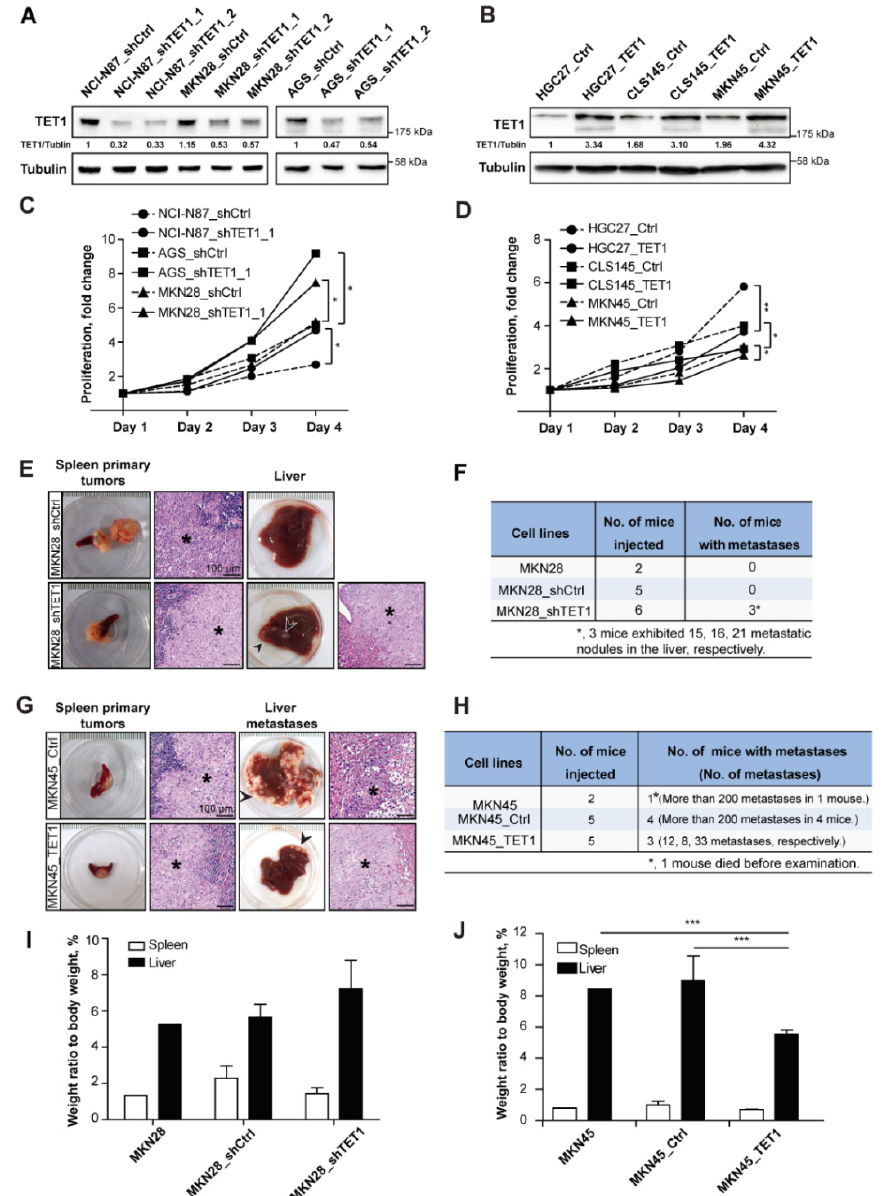
Figure 2. Knocking-down TET1 promotes experimental metastasis, while TET1 overexpression inhibits metastasis in the liver. ( A ) Immunoblot analysis showing TET1 expression in NCI-N87, MKN28, and AGS cells transduced with shTET1 or scrambled shRNA as control (shCtrl). α -Tubulin was used as loading control. ( B ) Immunoblot analysis showing TET1 expression in HGC27, CLS145, and MKN45 cells transduced with ectopic TET1-expressing or empty vector as control (Ctrl). α -Tubulin was used as loading control. ( C , D ) Relative cell proliferation rates of stable cell lines. ( E , G ) Representative pictures of tumors and H&E staining showing primary tumors in the spleen and metastatic tumors in the liver of mice injected with MKN28 stable cell lines ( E ) or with MKN45 stable cell lines ( G ). Asterisk represents tumor tissue. Scale bars represent 100 µ m. ( F , H ) Case numbers of mice with metastases injected with MKN28 stable cell lines ( F ) or with MKN45 stable cell lines ( H ). ( I , J ) Relative weight of spleens (spleen/body weight) and livers (liver/body weight) in ( E ) or ( G ). Error bars indicate mean ± SD. ***, p < 0.001. **, p < 0.01. *, p <